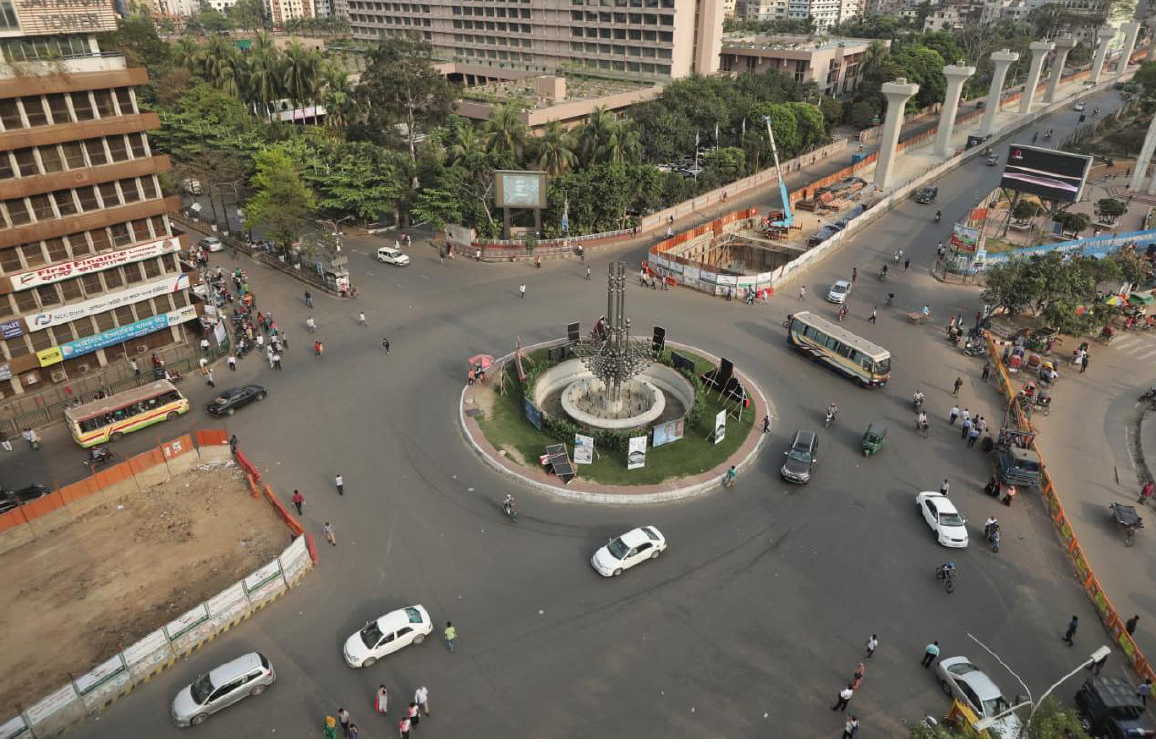
Figure 2: New modes of transport being added in Dhaka. The photo shows the ongoing construction work of elevated MRT at the Karwan Bajar node. Image courtesy: Dhaka Tribune The importance of well-designed pedestrian circulation is beyond doubt here. If we can nudge in a wider buffer (fig. 3 & 4) between the footpath and vehicular circulation, it benefits both the pedestrians and the biodiversity. These buffers or bio-swales need to be “soakable” areas where stormwater soaks in as much as possible and surface run-off water amount is reduced. Apart from providing extensive ecological services as microclimate regulation, wildlife habitat and biodiversity, they also serve the purpose of educating people and enhancing the aesthetic value. (Lovell et al.,